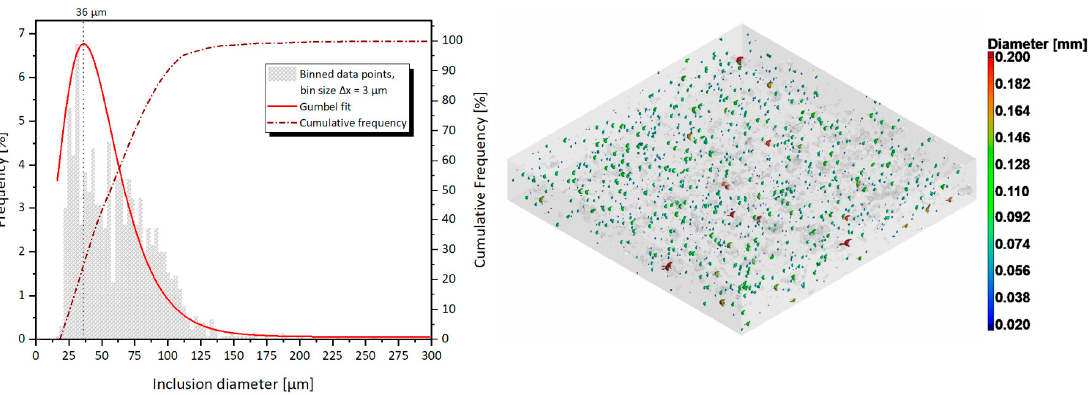
Figure 11. Inclusions size distribution inside the CN2-CuCr1 specimen; the percentage frequency and cumulative frequency are plotted together with a color-coded 3D view (right side).